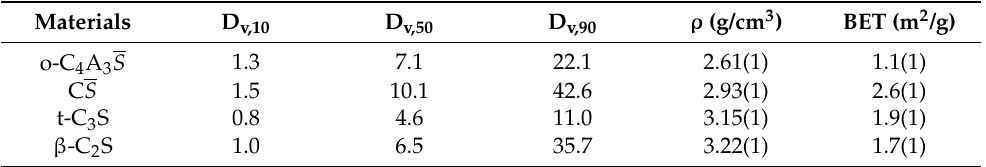
Table 2. Particle size distribution details, density and specific surface data of the employed anhydrous cement samples *.